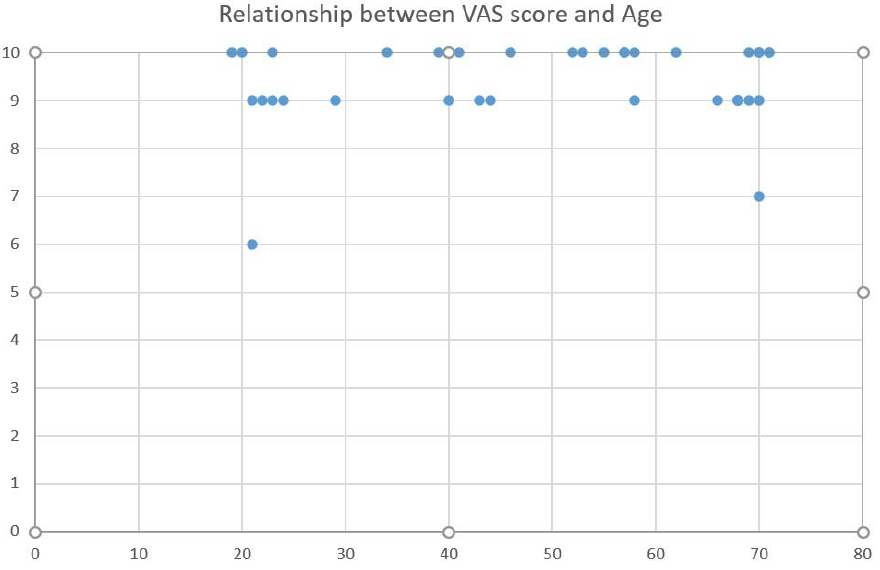
Figure 4. Relationship between VAS score and age.